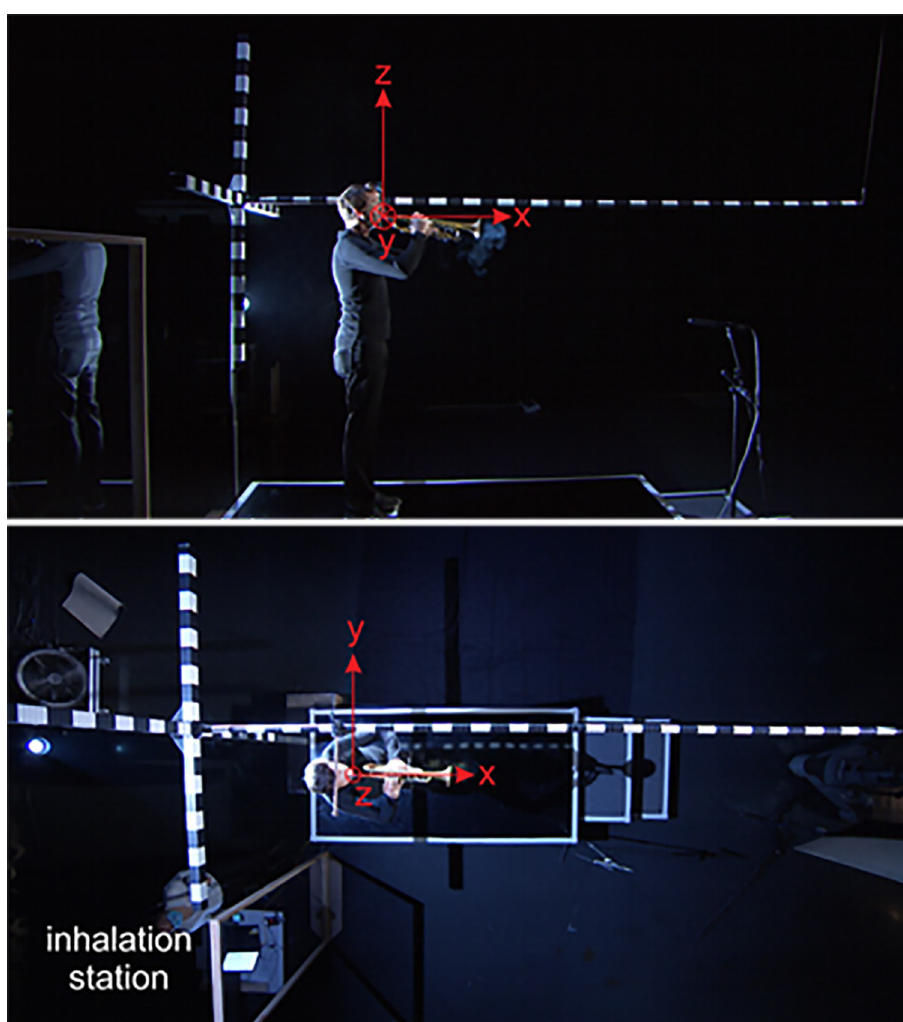
Fig 2. Pictures of a trumpeter in the side view (upper) and top view (lower) perspective. The origin of the coordinate system was placed at the mouth opening of the instrument